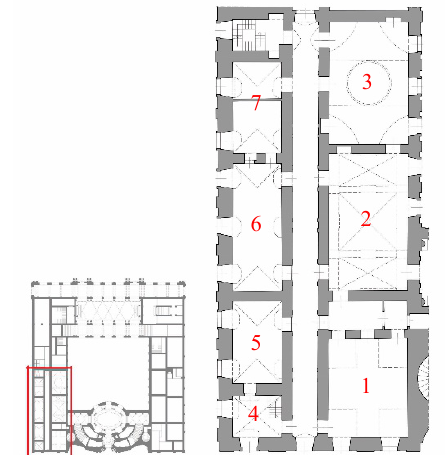
Figure 13. Polylines grid generated from 3DReshaper - ‘Prima Anticamera’ (Modelling: F. Natta) Figure 14. The ‘Appartamento di Mezzanotte’ in Palazzo Carignano, floor plan (Drawing: F.